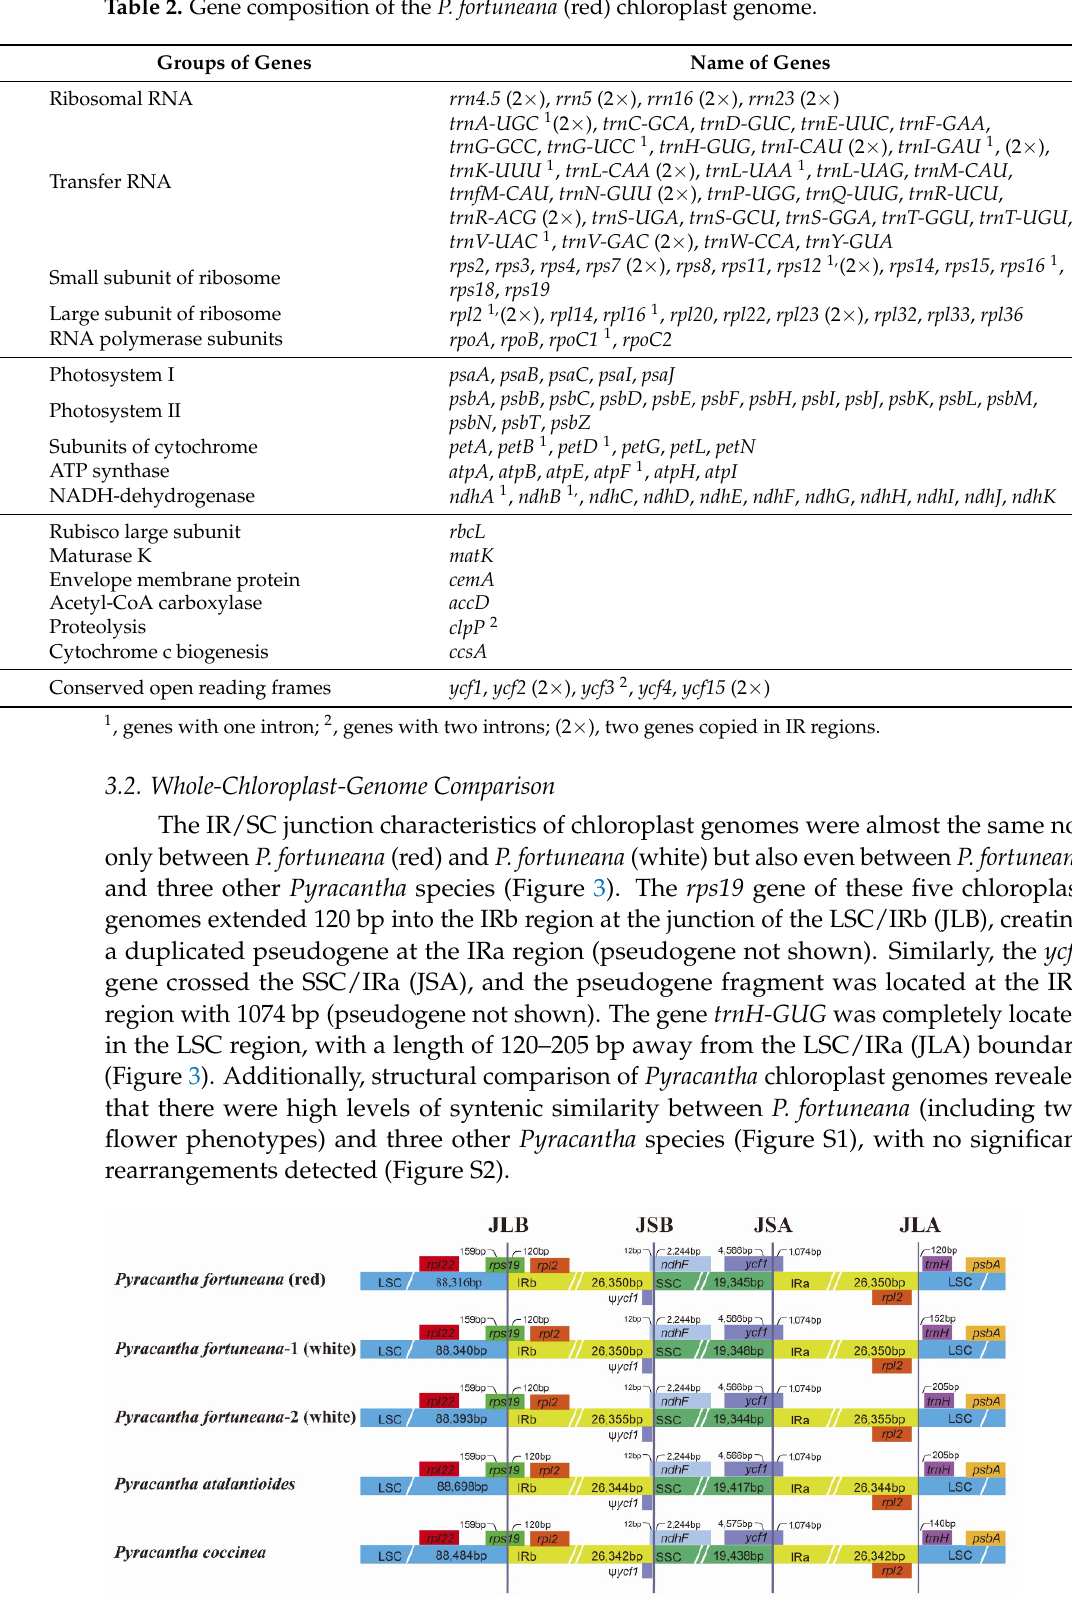
Figure 3. Comparative junction characteristics of LSC, SSC, and IR regions of chloroplast genomes between three accessions of P. fortuneana and two other Pyracantha species. JLB, JSB, JSA, and JLA represent four different junction regions in the chloroplast genome boundaries.